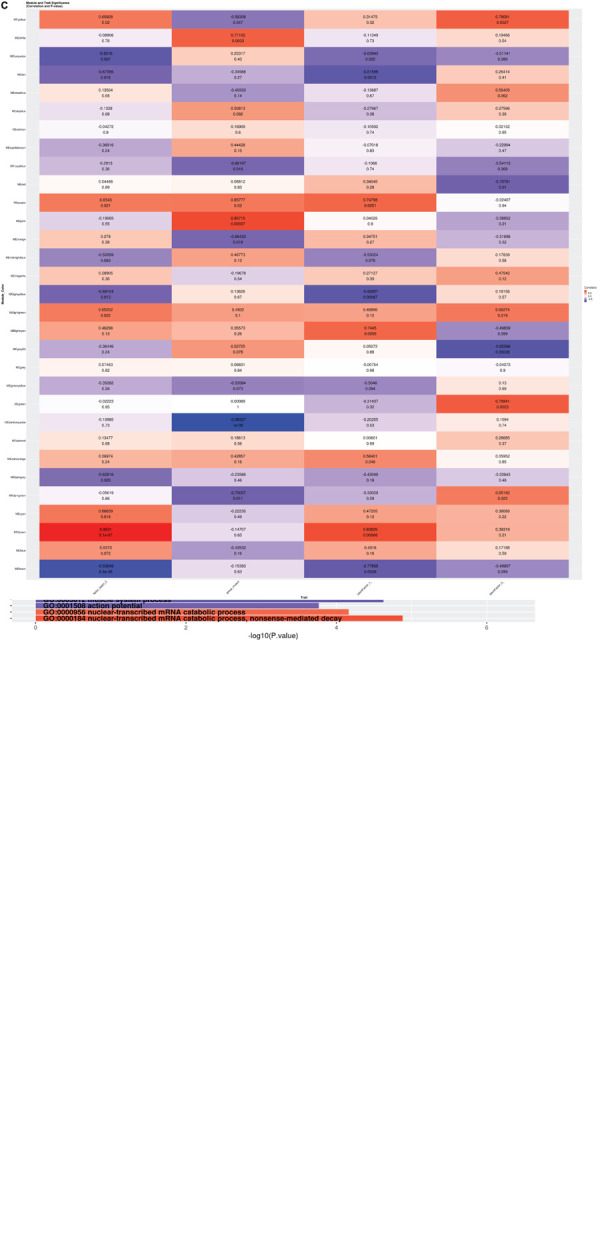
(A) Volcano Plot: Volcano plot of 15,942 gene transcripts with log 2 fold changes observed by Limma. 7,141 were differentially expressed between patient and control neurons (FDR ≤ 0.05). Among these transcripts, 6,500 genes were protein-coding. Out of these, 161 were down-regulated (Blue) and 36 were up-regulated (Red) by 3-fold or more. (B) Global GO Biological Process Perturbation Bar Plot: All 15,942 transcripts were interrogated by Gage for level perturbations across all known GO biological process gene sets. The significance and mean log 2 fold change of each term was evaluated by t-tests. (C) Module and Trait Eigengene Correlation and Significance Matrix: Matrix of de novo color coded modules found by WGCNA and their respective eigengene Pearson correlation (top value in each cell) and p-values (bottom value in each cell) for the mutation and statistical covariates. Bright red modules are high positively correlated and bright deep blue are high negatively correlated transcripts. Modules with absolute value Pearson correlations greater than 75% to the mutant samples (pink, white, and darkturquoise) were considered the best candidates for further investigation.